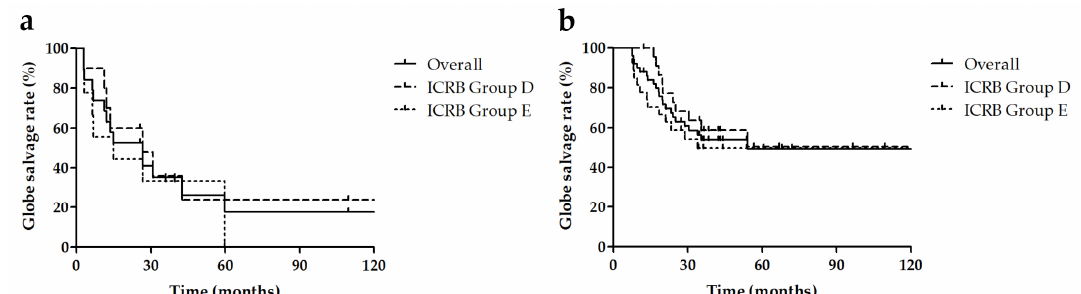
Figure 1. Kaplan–Meier curves showing the globe-salvage rates ( a ), recurrence-free rates ( b ), and metastasis-free rates ( c ) of advanced retinoblastoma based on whether patients were diagnosed before or after 2010.